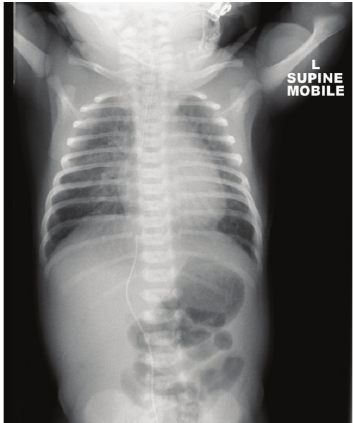
Figure 1: Chest X-ray and abdominal X-ray at two hours of age. The endotracheal tube tip is in the right main bronchus and was withdrawn 15–20 mm. The cardiothalamic silhouette is normal and lung and pleural spaces are clear. No pneumothorax is seen. The umbilical venous catheter lies to the right of the midline at T10.